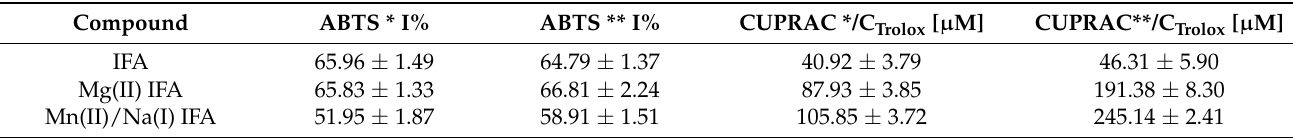
Table 5. Antioxidant properties of isoferulic acid (IFA), Mg(II) IFA, and Mn(II)/Na(I) IFA determined using ABTS and CUPRAC assays (the concentration of tested substances in the samples was: * 10 µ M, ** 20 µ M).